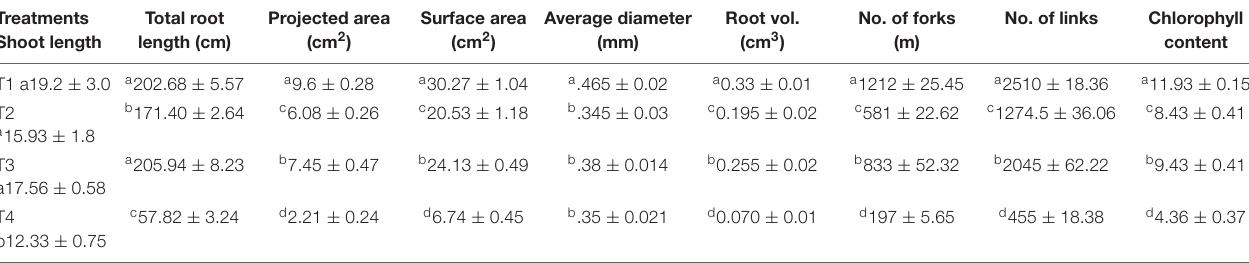
TABLE 6 | Effect of E. profundum PHM11 inoculation on plant growth promotion and physiological attributes of rice. Treatments Total root Projected area Shoot length length (cm) (cm 2